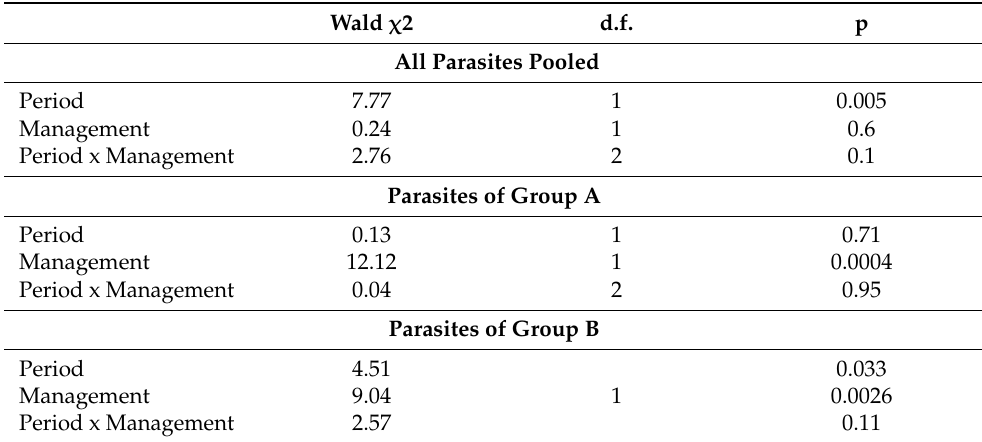
Table 2. Generalized linear model (GLZ) for effects of period and management on infection by avian malaria parasites in red-legged